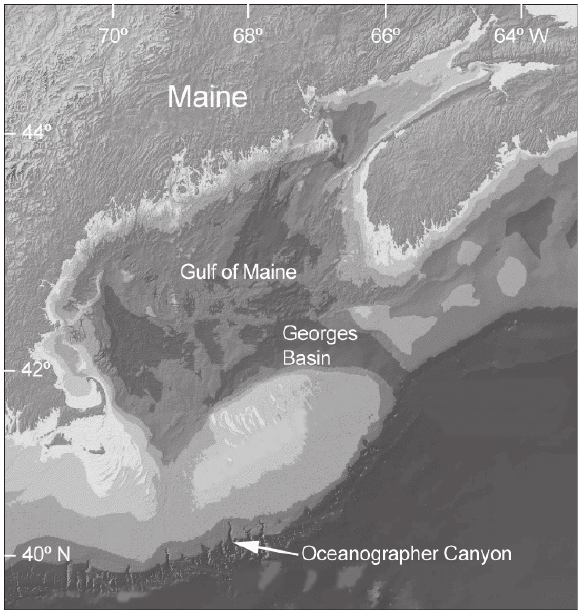
Fig . 1. – Study area showing locations of